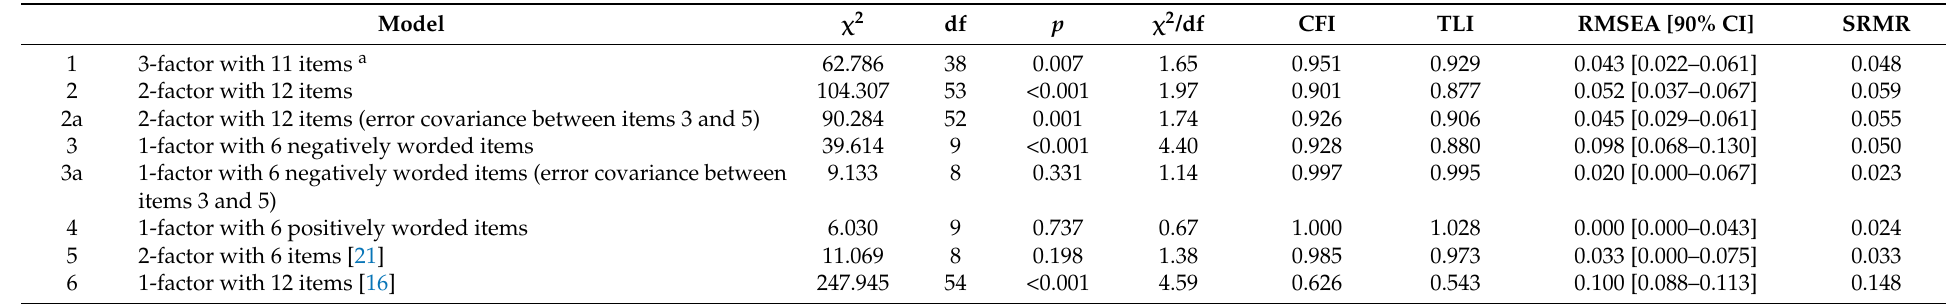
Table 2. The fit indices for the alternative models of the McMaster Family Assessment Device-General Functioning Subscale using